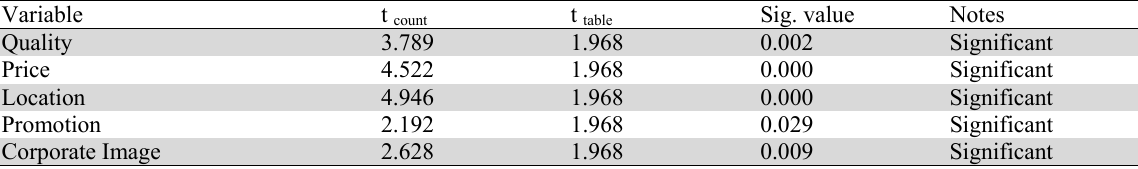
The results of t-student